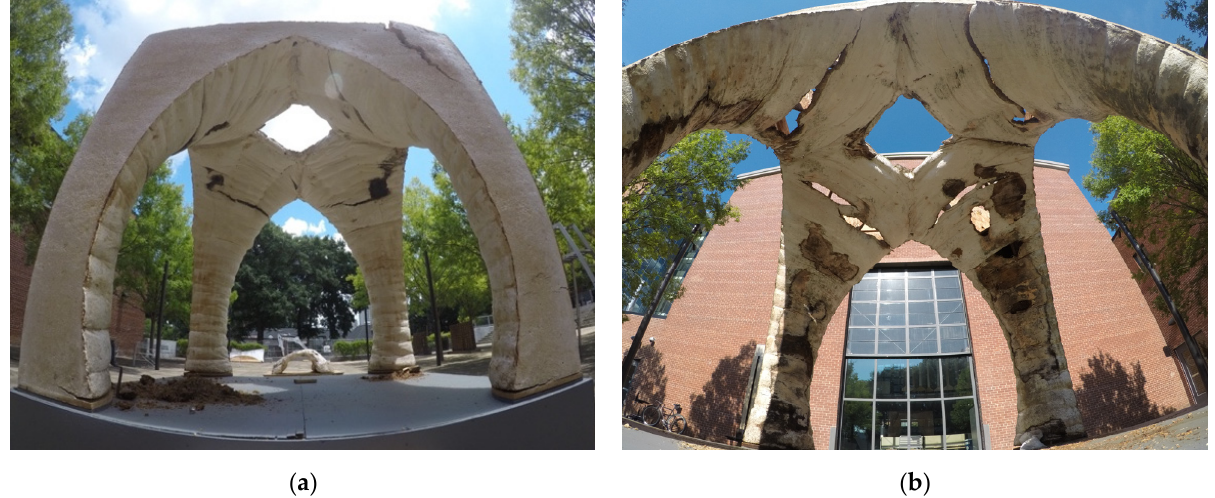
Figure 3. Decay of the Monolito Micelio. ( a ) Cracking and decay of the structure after three months caused by expansion and contraction of the material matrix against the internal reinforcing structure; ( b ) cracking, decay, and infestation of the structure after four months. Photos by the author.